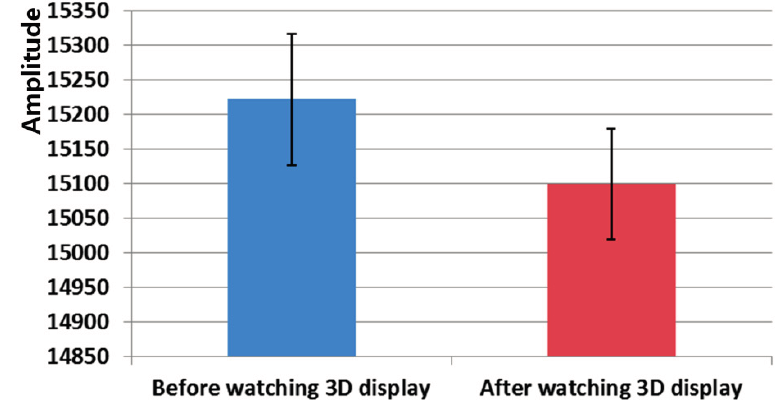
Figure 12. Comparison of FT amplitude before and after watching the 3D display.